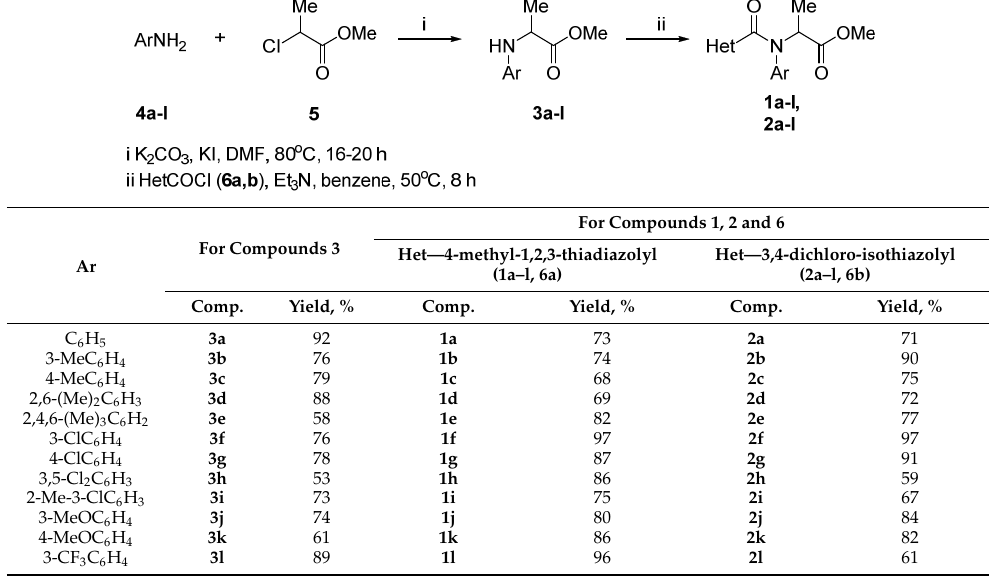
Table 2. Synthesis route of the target compounds 1a – l and 2a – l .